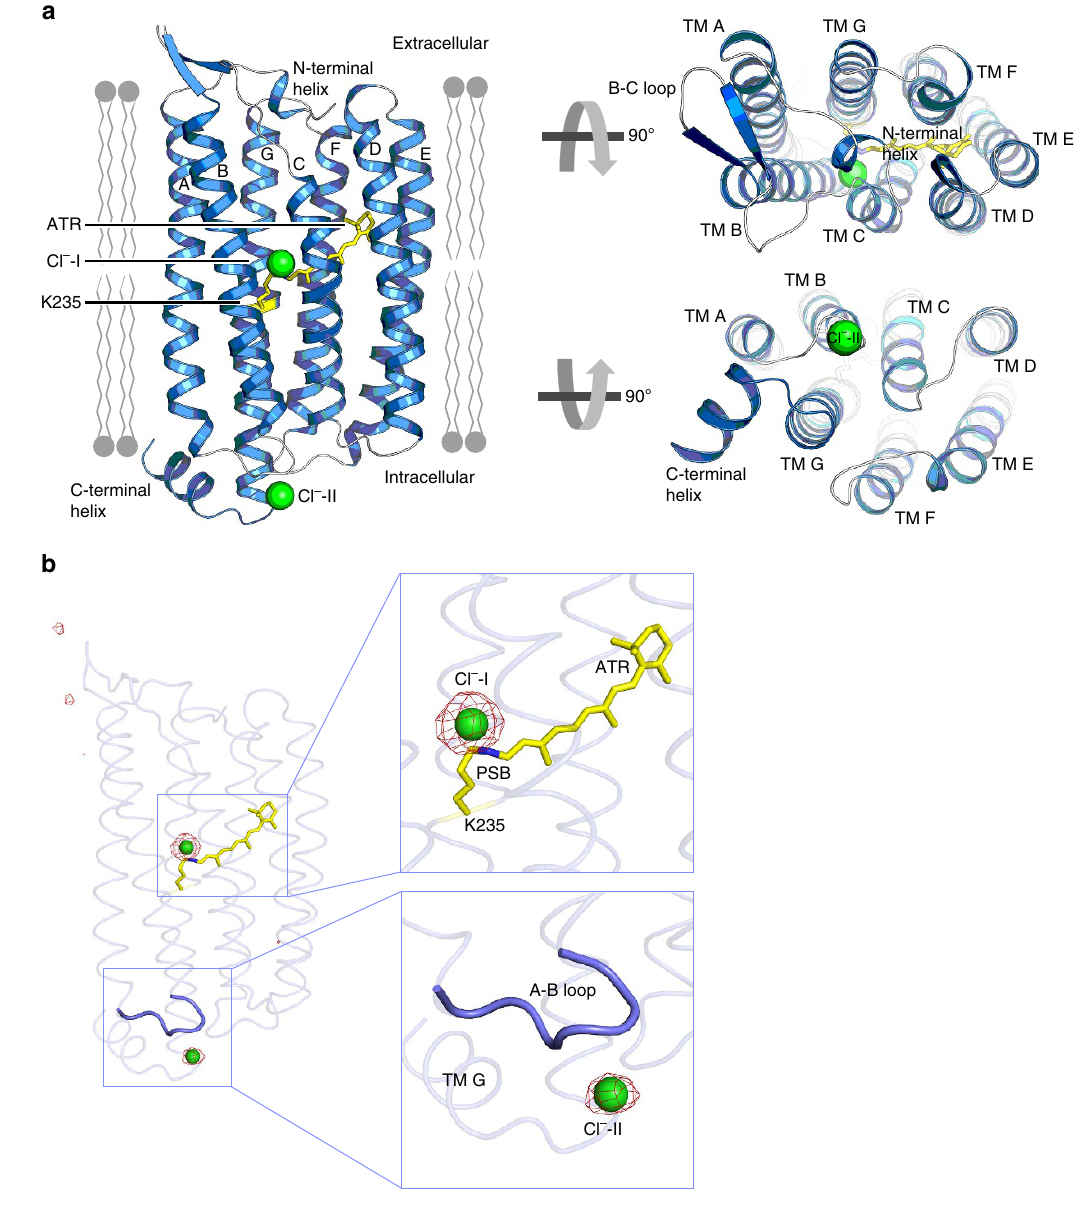
Figure 1 | Crystal structure of the ClR. ( a ) ClR structure in a ribbon model. Transmembrane helices A–G (TM A–TM G) are indicated and the putative membrane parts are drawn schematically. ( b ) Anomalous difference Fourier map of Br (cid:2) shown as red meshes (contoured at 5.0 s ). Magnified views of the peaks of the map are shown in boxes. Two chloride ions bound to ClR structure are depicted by green spheres. All- trans retinal (ATR), linked covalently to K235, is shown in a yellow stick